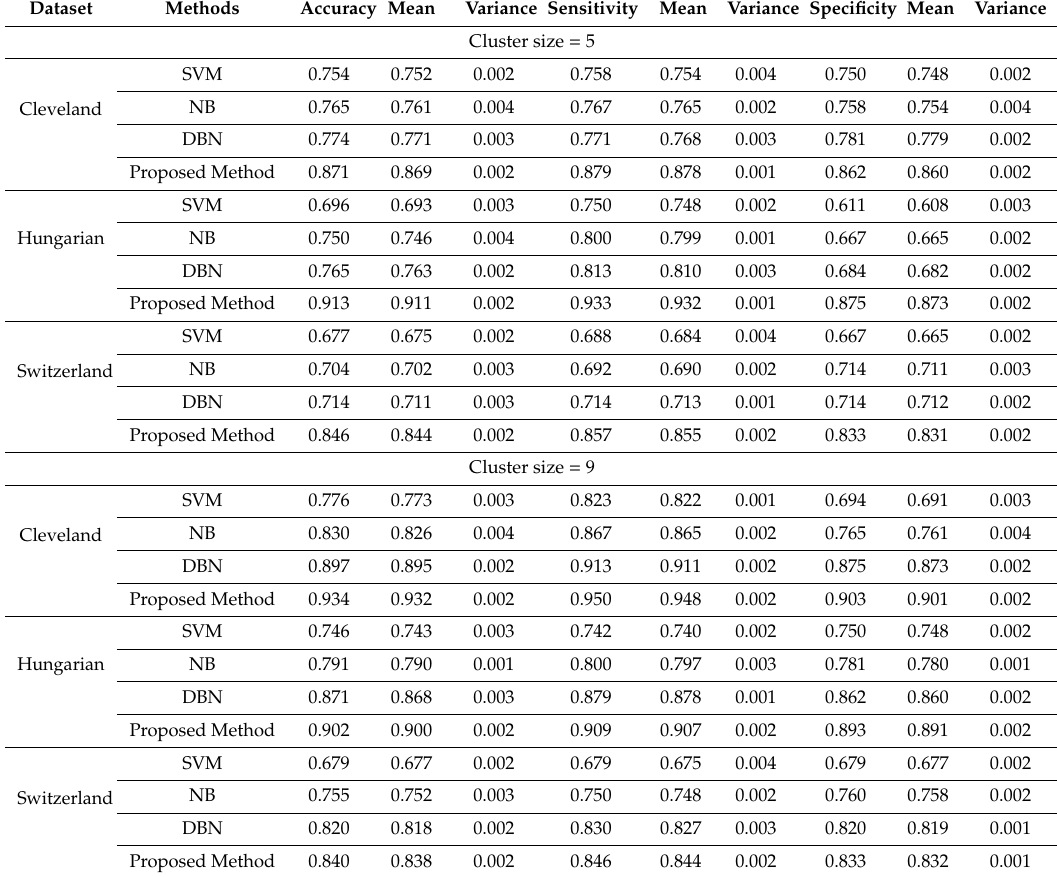
Table 12. Statistical